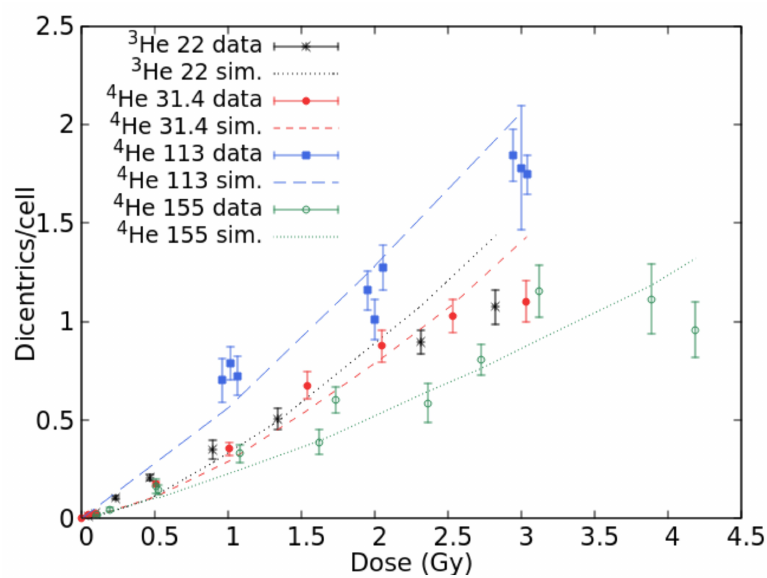
Figure 2. Mean number of dicentrics per cell versus dose for He-ion beams with LET values of 22.0, 31.4, 113.0, and 155.0 keV/ µ m. The points with error bars are experimental data, and the lines are simulation